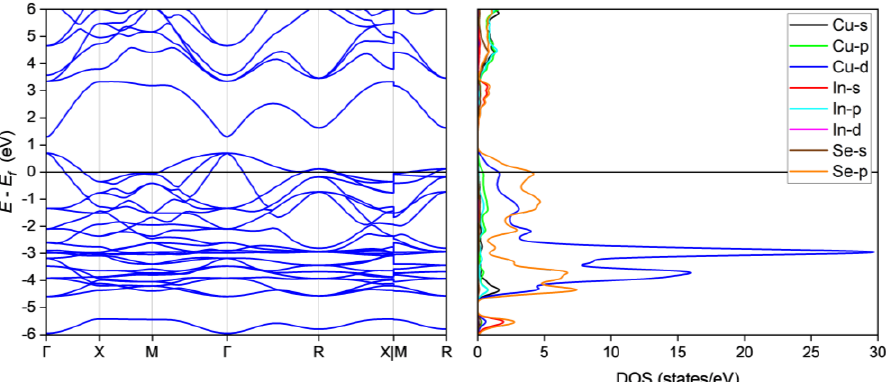
Figure 3. Calculated energy band structure and orbital-projected DOS.